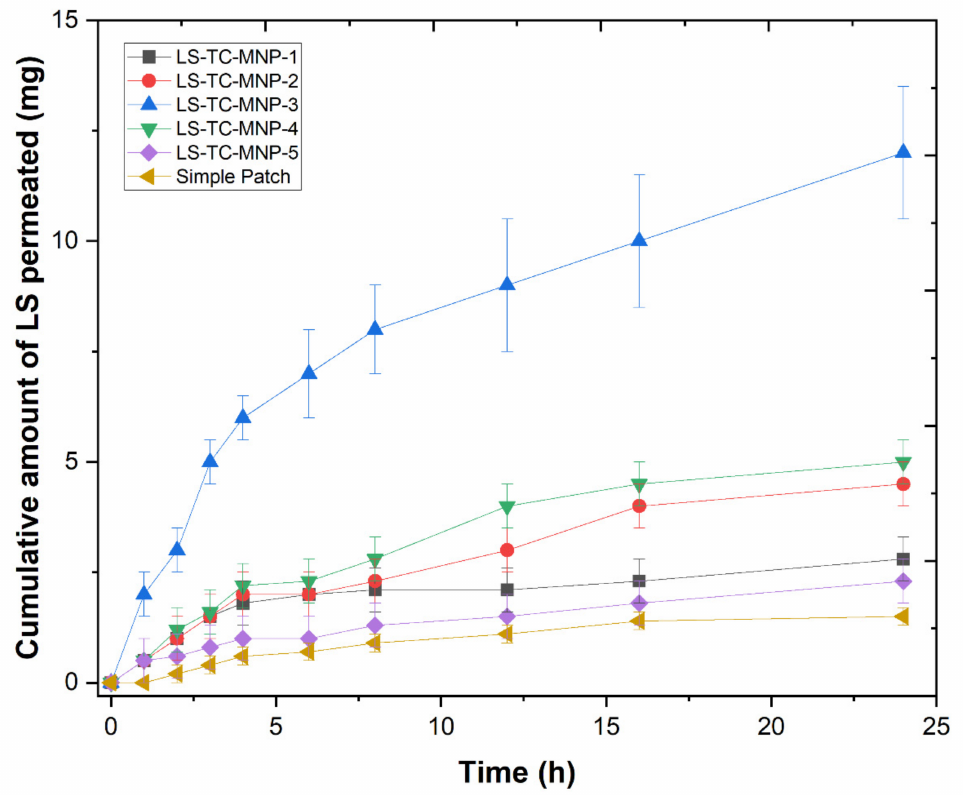
Figure 15. Graph showing cumulative amount of drug permeated vs. time through mice skin from the five LS-TC-MNPs fabricated with different concentrations of thiolated chitosan (means ± , n =